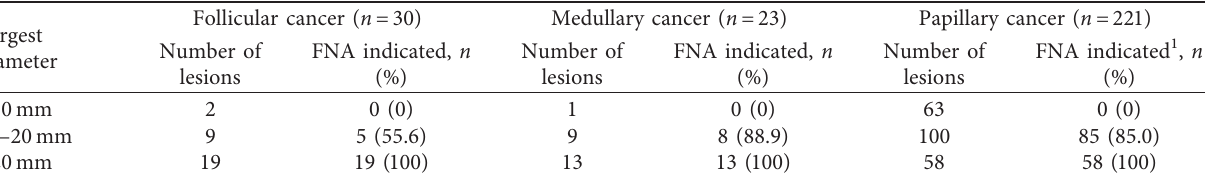
Table 3: EU-TIRADS-based indication of FNA. Both the EU-TIRADS score and nodule size influence the indication. Largest